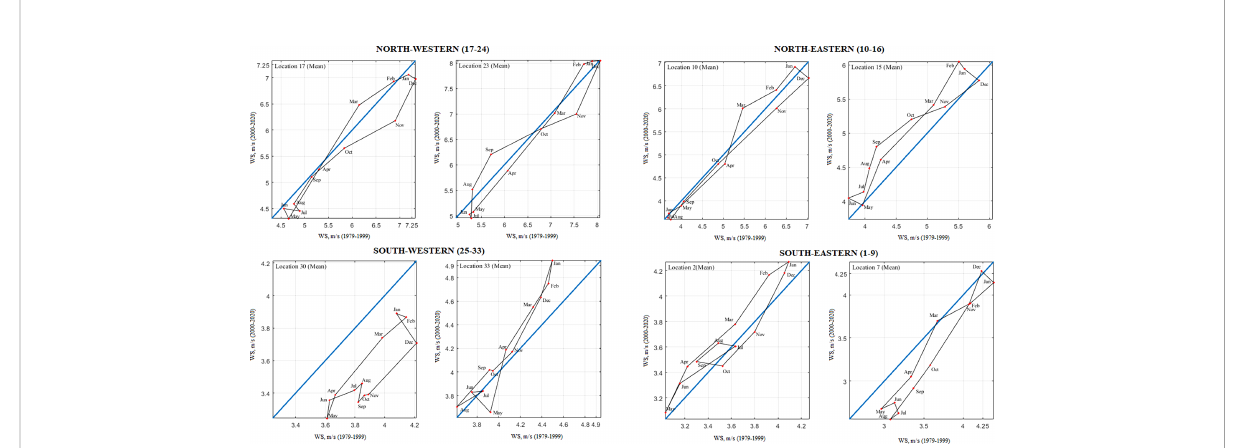
FIGURE 8 IPTA results for monthly mean WSs during 42 years between 1979 and 2020.